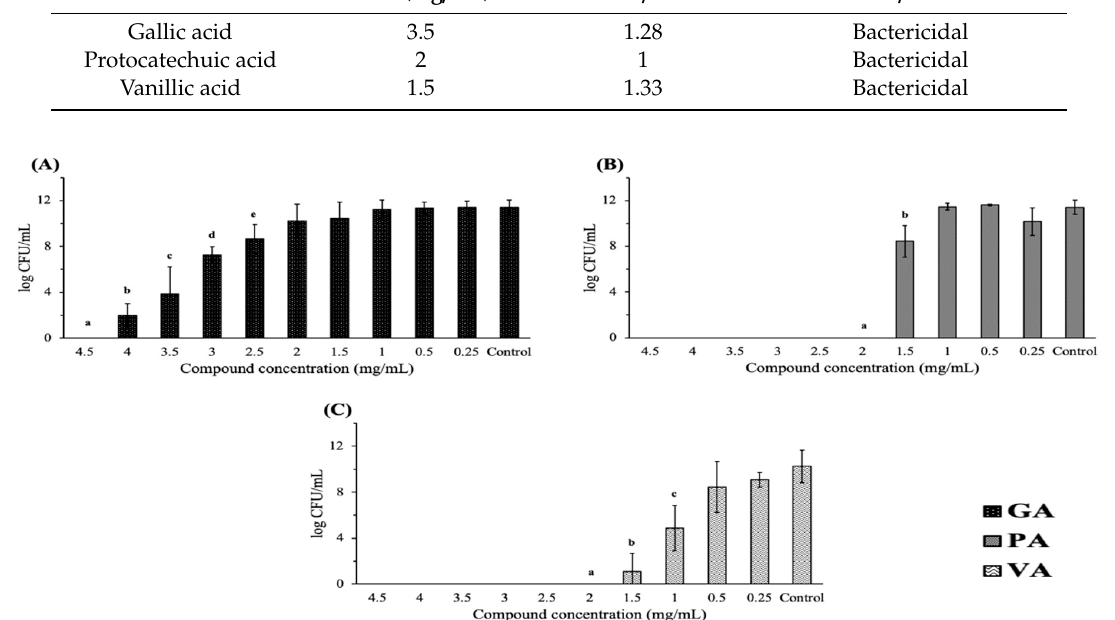
Figure 1. Concentration-dependent antimicrobial evaluation for individual phenolic compounds by determining minimum bactericidal concentration (MBC) (log CFU/mL) for Salmonella enterica serovar Typhimurium (ST) treated with increasing concentrations (0.25–4.5 mg/mL) of gallic acid (GA) ( A ), protocatechuic acid (PA) ( B ) and vanillic acid (VA) ( C ). Letters denote statistically significant difference ( p < 0.05) as compared to control and between concentrations (a–e).